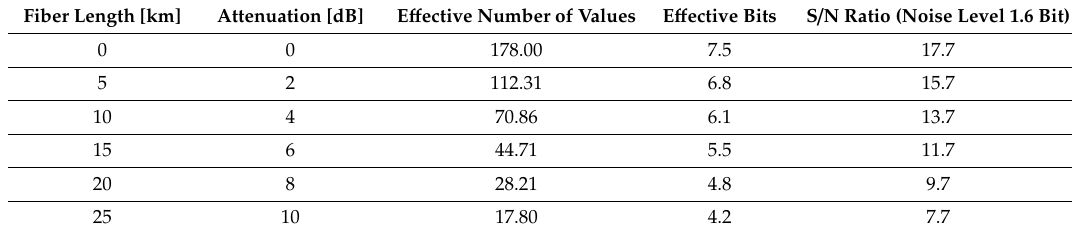
Table 2. Signal-to-noise (S / N) ratio, e ff ective bits and e ff ective number of values at the end of a fiber for various fiber